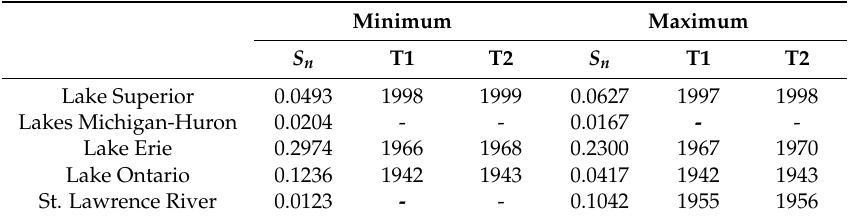
Table 1. Lombard test results for monthly mean water levels in four North American Great Lakes over the period from 1918 to 2012. Analysis of mean